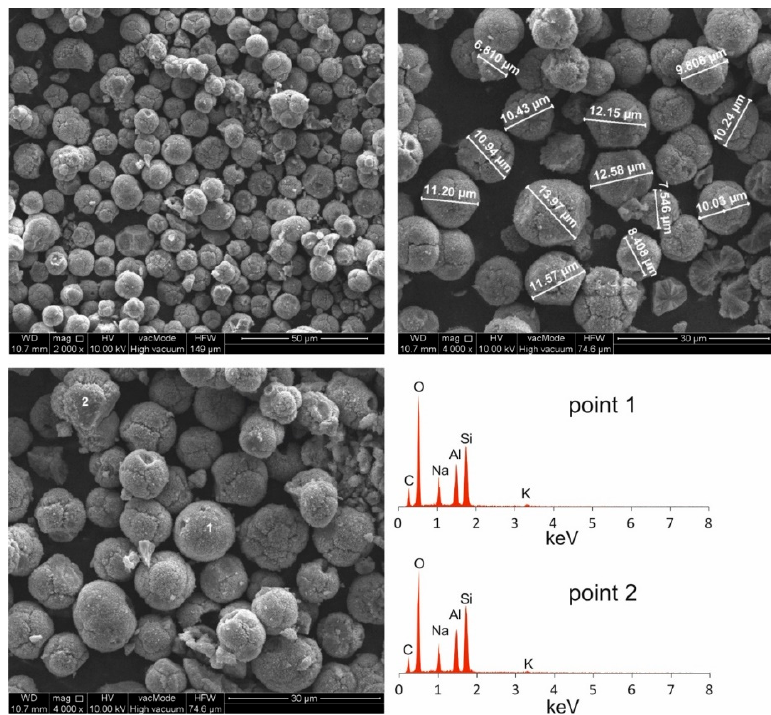
Figure 4. Morphological analyses of Na ‐ P1.